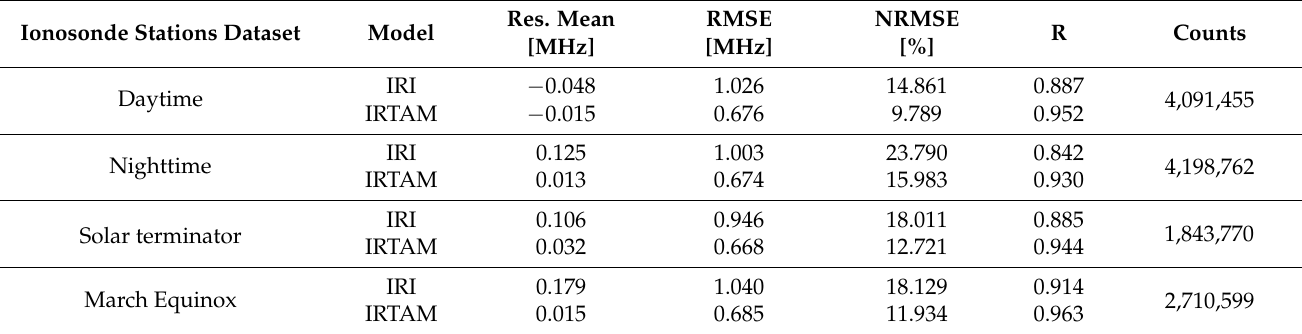
Figure 3. Density plots between measured ( x -axis) and modeled ( y -axis) fo F2 values, for ( a ) IRI and ( c ) IRTAM. Measured values are those from the entire ionosonde dataset. The black solid lines represent the best linear fit. Corresponding slope and intercept values, along with the correlation coefficient, are reported in the upper left box of each plot. Statistical distributions of the resultant residuals for ( b ) IRI and ( d ) IRTAM. Corresponding Res. Mean , RMSE , and NRMSE values, along with the total number of counts on which the statistics is based, are reported in the upper left box of each plot. Table 2. Res. Mean, RMSE , NRMSE , and R values calculated for the IRI and IRTAM models on the basis of the fo F2 ground-based ionosonde observations, for the bins defined in Section 4.2, according to the three levels of solar activity defined in Section 3.1, and for the full dataset (bottom row). The number of counts on which the statistics were calculated is reported in the rightmost